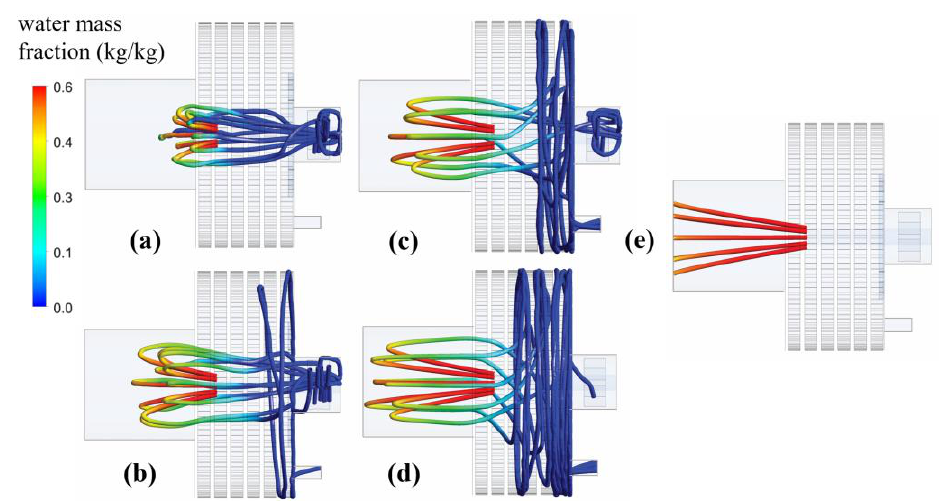
Figure 15. Residence Time Distribution (RTD) of particles leaving the dryer in case “F”: ( a ) via gas outlet; ( b ) solids outlet.